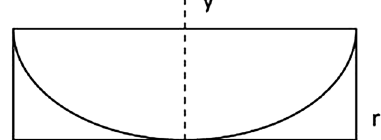
FIG. 3. A diagram of the trough. The water in the trough has a parabolic shape, y ¼ ar 2 , and in the third dimension (into or out of the page), the trough has a constant depth D ¼ 0 : 6 cm . The trough is sitting on a turntable, which is rotating.